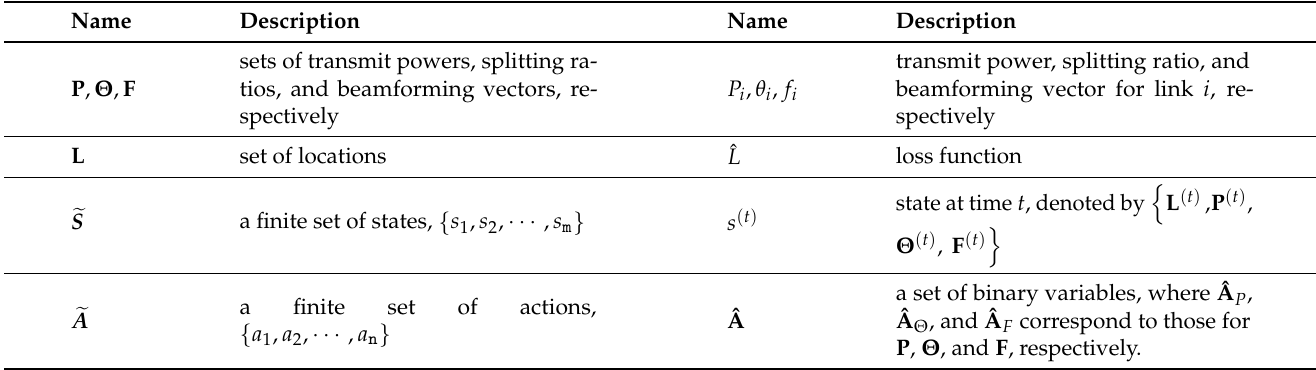
Table A1. Important symbols for the proposed approaches in this